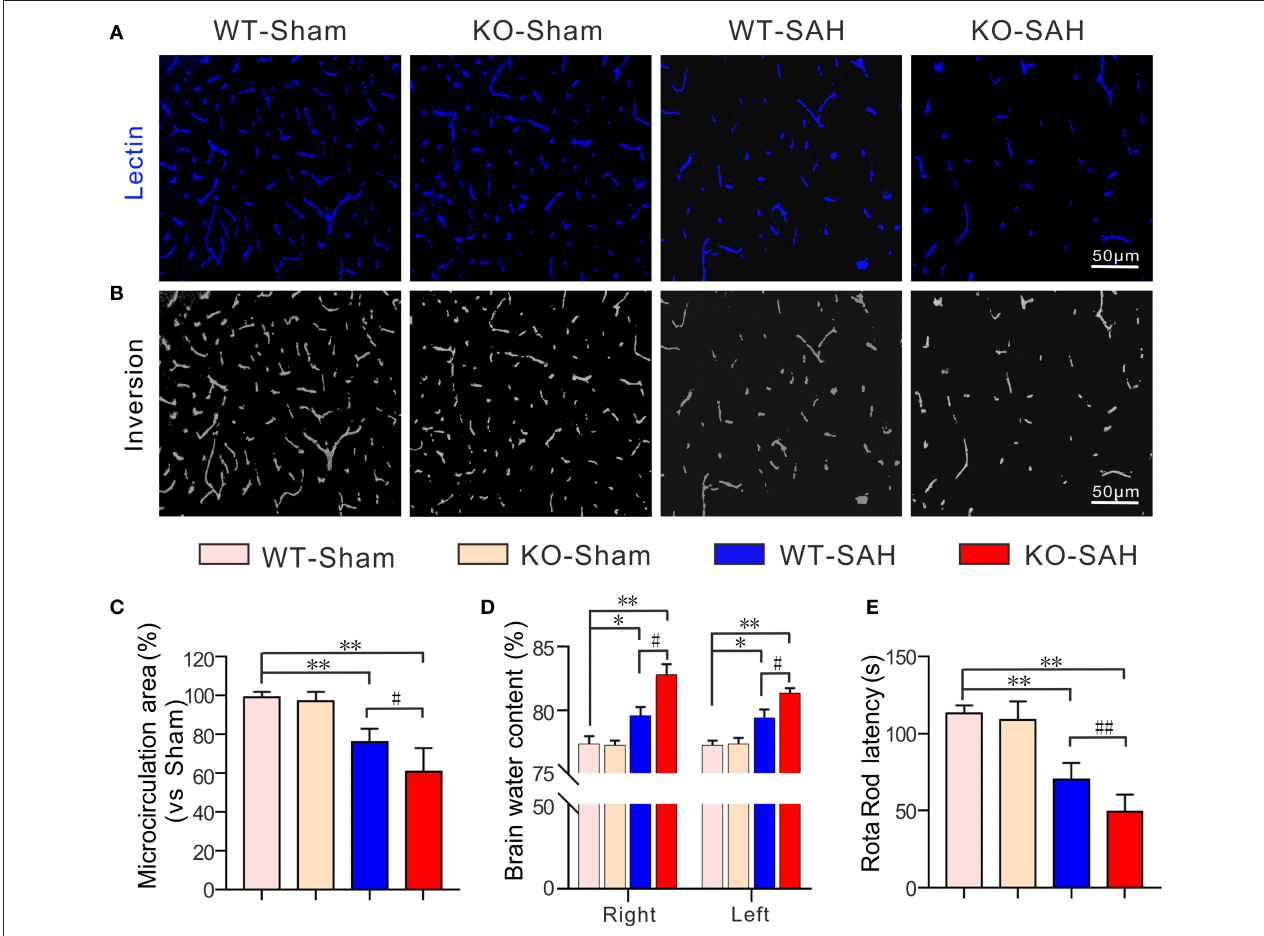
FIGURE 2 | ApoE deficiency promotes effective microcirculation perfusion area reduction after SAH. (A) Representative pictures of the intravital lectin perfusion study for evaluating the effective microcirculation area in WT mice and ApoE-deficient mice 48h after SAH. (B) Corresponding grayscale inversion images of the pictures shown in (A) . (C) The quantification of the effective microcirculation perfusion area in each group. (D) The quantification of brain water content in each group. (E) The quantification of the rotarod latency in each group. Data are expressed as the mean ± SD, one-way ANOVA with Tukey’s post hoc , * p < 0.05, ** p < 0.01, vs. the WT-Sham group; # p < 0.05, vs. the WT-SAH group; n = 5 per group; Right, right hemisphere; Left, left hemisphere; scale bar =